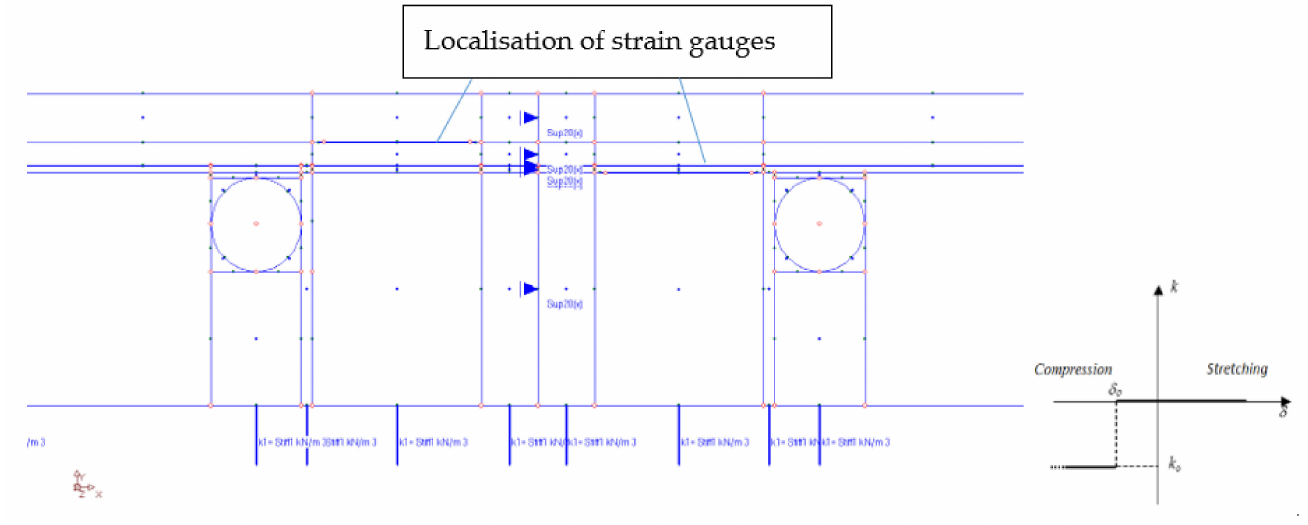
Figure 16. Measurement zone and substrate modelled by “contact zone”. k , k o —spring stiffness; δ , δ o